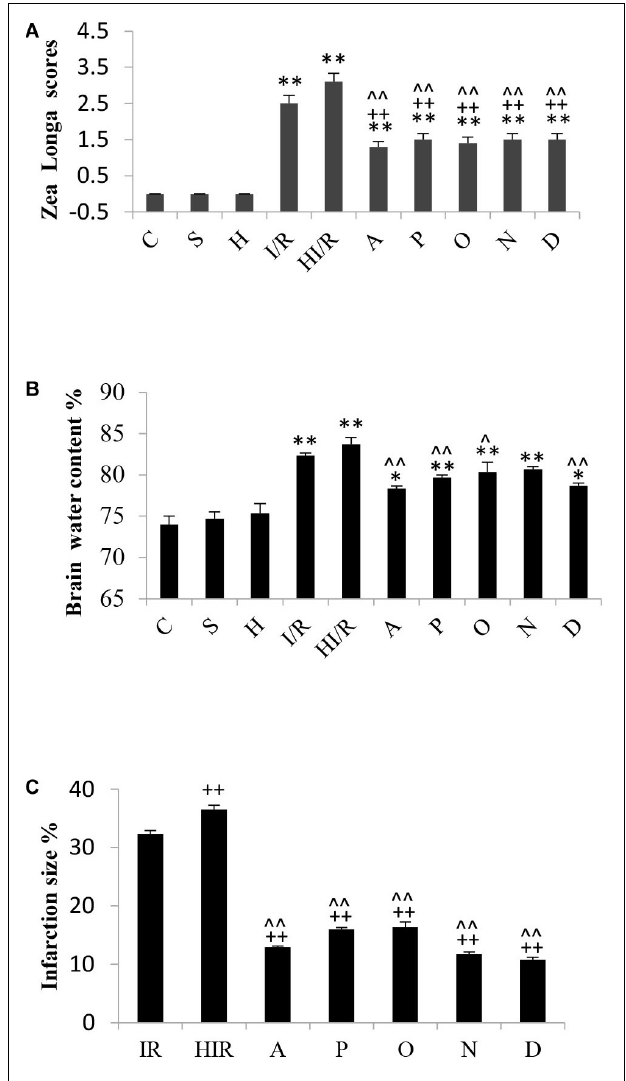
FIGURE 3 | Changes of brain tissue and neurological function in rats 24 h after I/R or not. (A) A significant increase of Zea Longa scores appeared in I/R and HI/R groups compared to control groups, especially in the latter, and decreased by all inhibitors ( n = 10, P < 0.01). (B) The water content of brain tissue increased evidently in I/R and HI/R groups compared to control groups ( P < 0.01), and decreased in A, P, O, and D groups when compared to HI/R group ( n = 3, P < 0.05 or 0.01). (C) The infarction size of cerebrum tissue in HI/R or I/R group was the first and second largest, separately, and decreased by all inhibitors ( n = 3, P < 0.01). ∗∗ or ∗ means P < 0.01 or 0.05 versus control, ++ or + means P < 0.01 or 0.05 versus I/R group, and ∧∧ or ∧